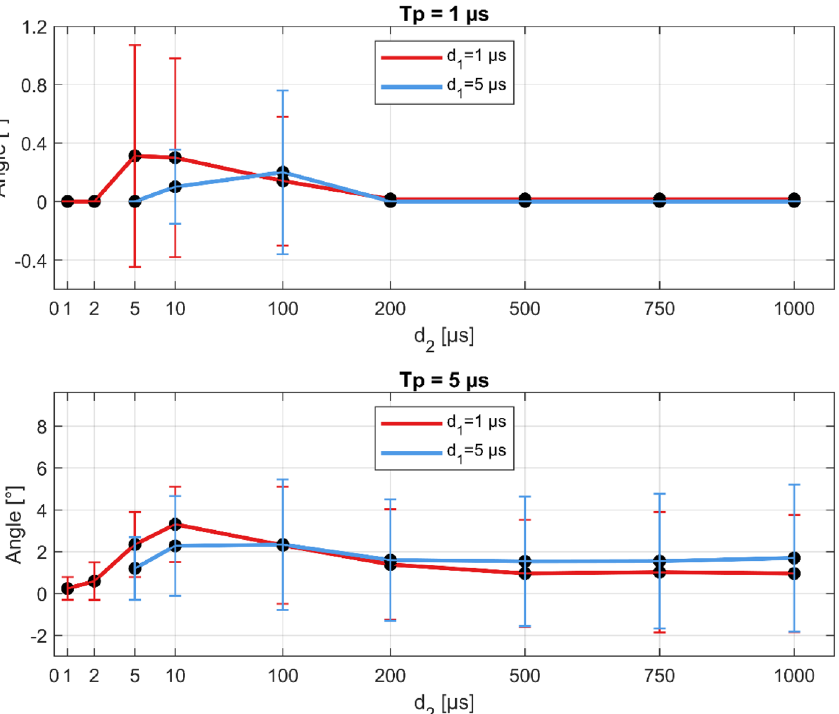
Figure 4. Longer interpulse delays reduce muscle contraction (response angle). Upper figure: 400 × 1 µs pulses, lower figure: 80 × 5 µs pulses. Note different ordinate scales (higher angles for T p = 5 µs). The results are shown as the mean (black dots) ± standard error (vertical bars). T p -pulse width, d 1 -interphase delay, d 2 -interpulse